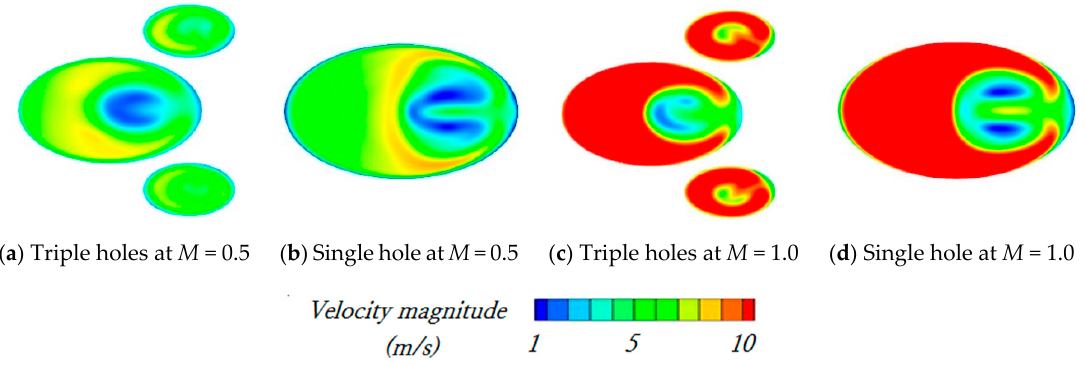
Figure 20. Cross-sectional contours of the mean velocity magnitude in the hole at y/D = − 0.2.